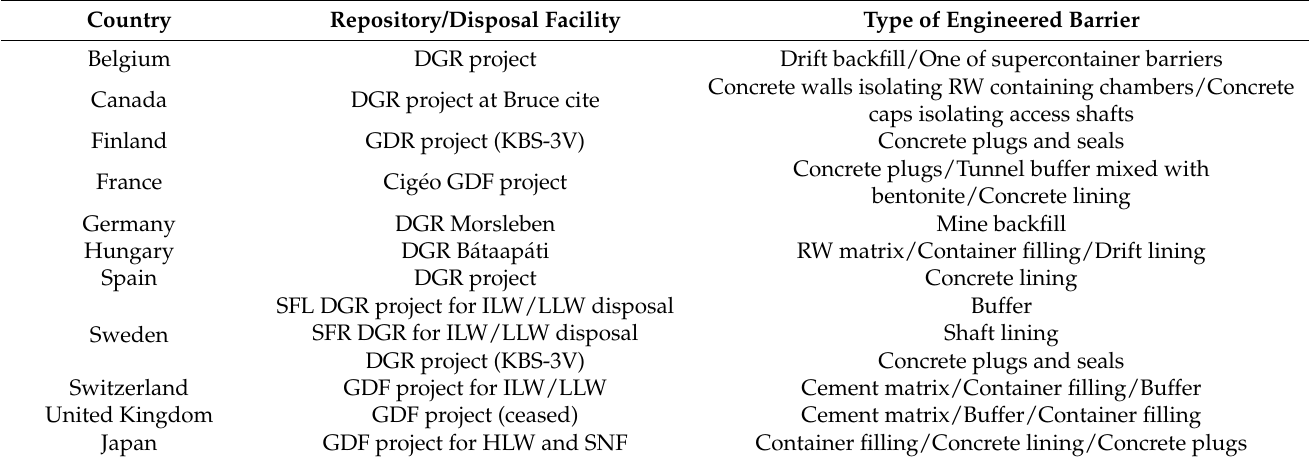
Table 4. Overview of the use of cement-based